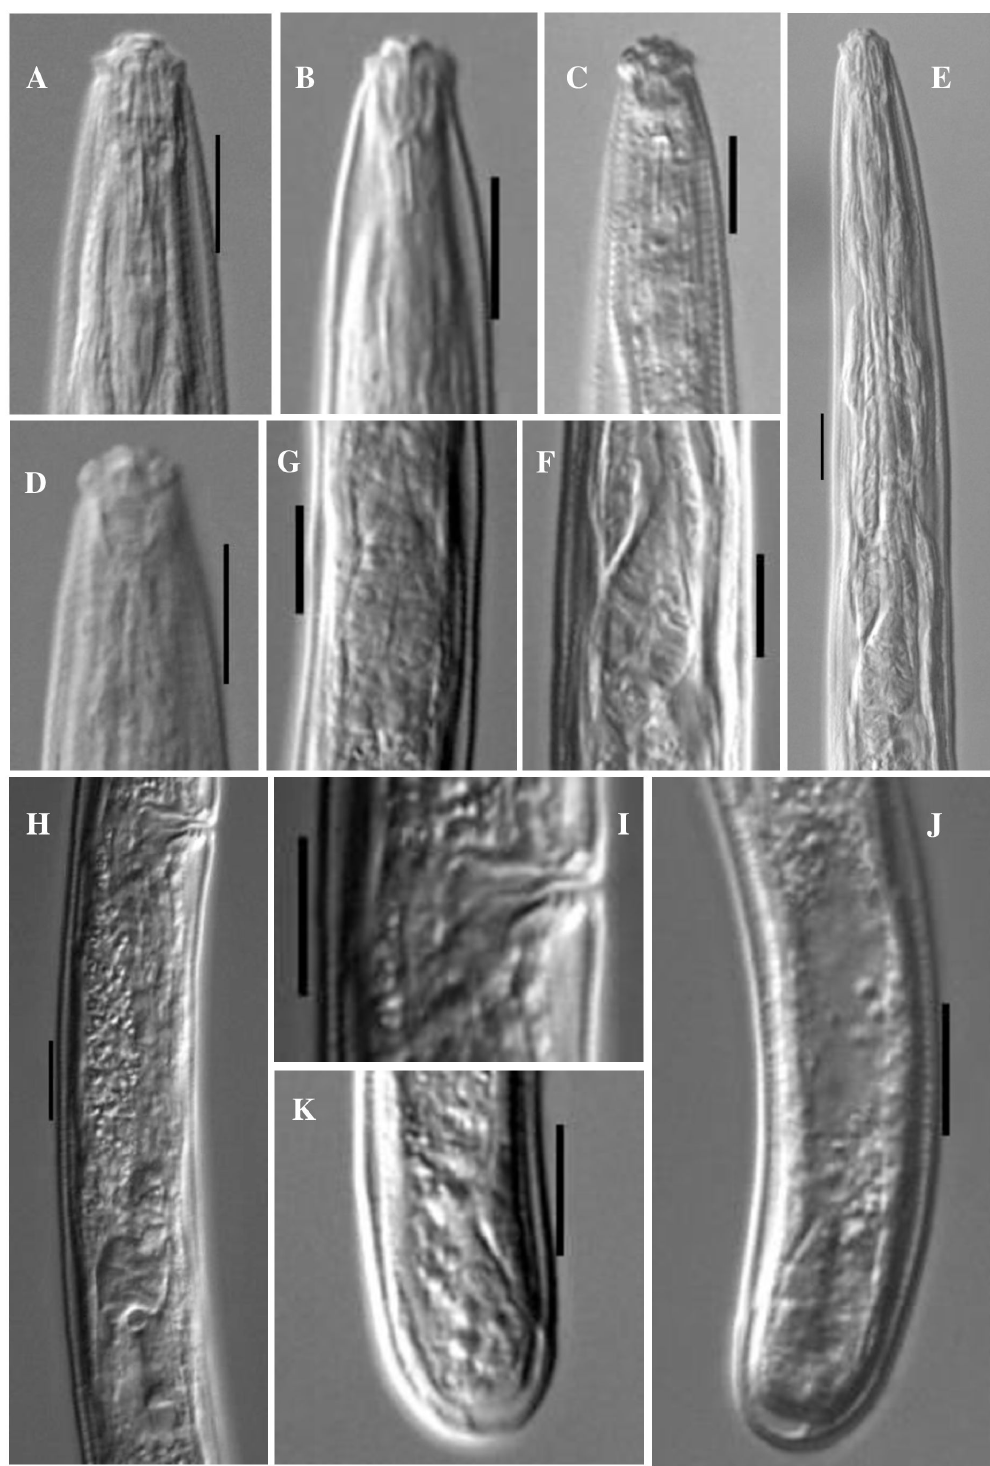
Fig. 4. Basirotyleptus ethiopicus Siddiqi, 1970, ♀ (AMU/ZD/NC/ Basirotyleptus ethiopicus /1–5) (LM photographs). A–C . Anterior region. D . Anterior region showing amphid. E . Pharyngeal region. F–G . Pharyngeal bulb. H . Genital system. I . Vulval region. J . Posterior region. K . Posterior end. Scale bars =10